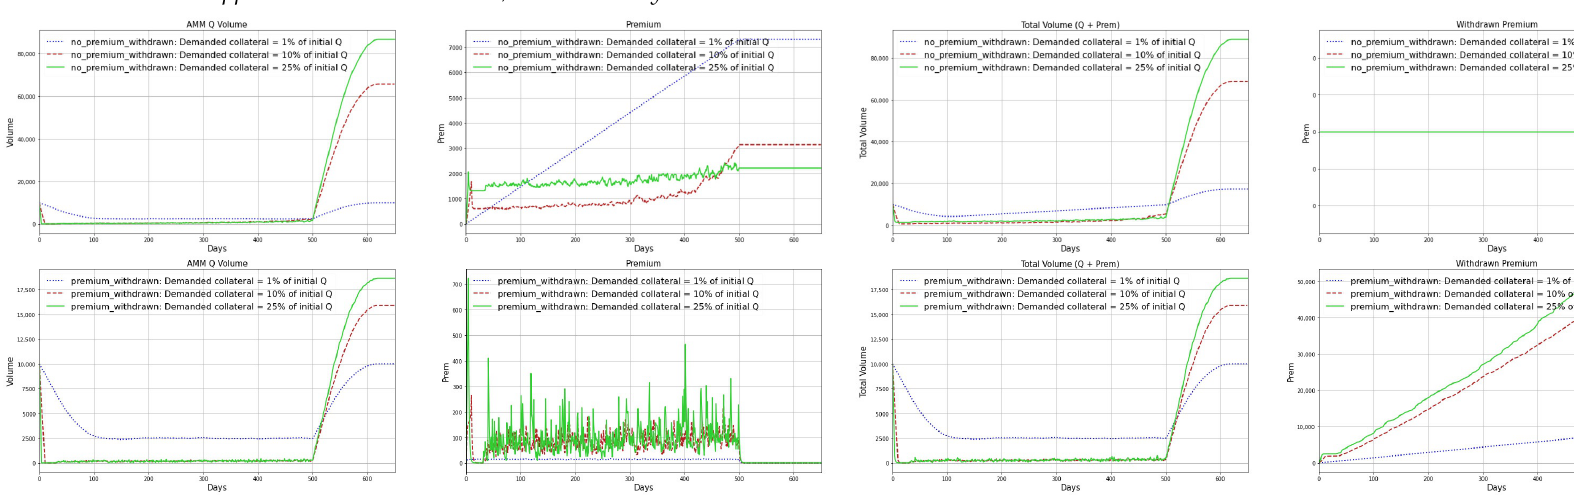
Figure A10. rkAMM Curves from simulation of scenario 4 and 1 day of withdrawal